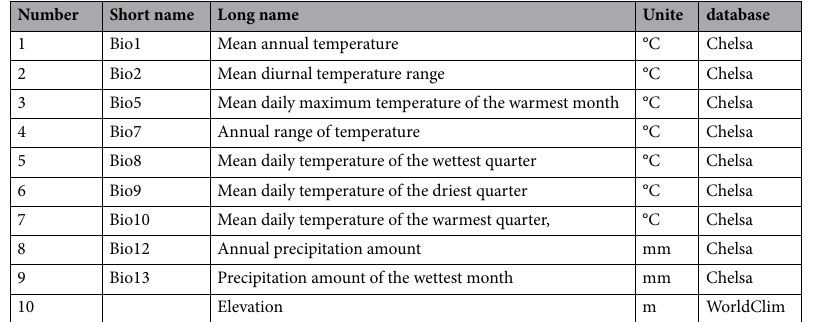
Table 1. Environmental variables were employed to model S. inflata distribution pattern in the two climatic times (2050 and 2080).